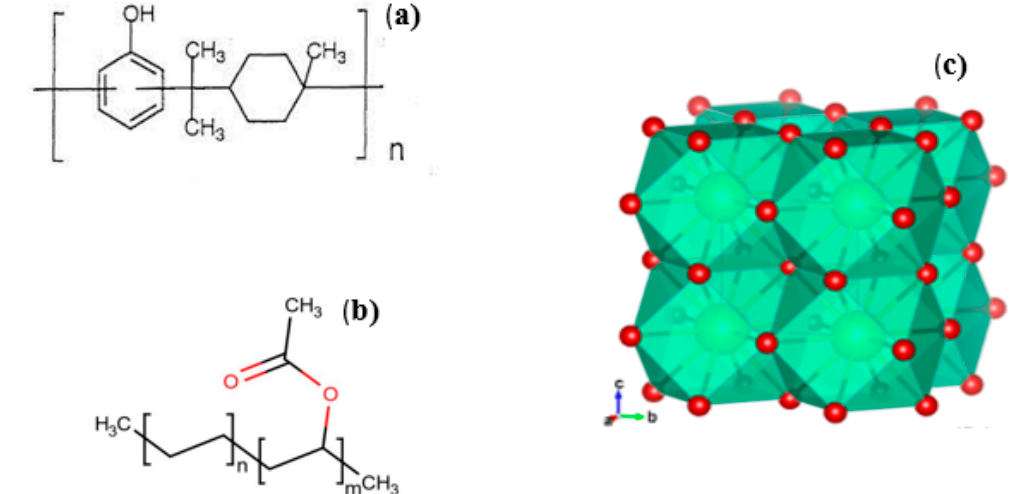
Figure 1. The molecular structures of ( a ) terpene phenol (TPR) and ( b ) ethylene vinyl acetate (EVA) obtained using the MarvinSketch 20.4 software and ( c ) the crystal structure of a unit of cesium lead tribromide (CsPbBr 3 ) drawn with the VESTA